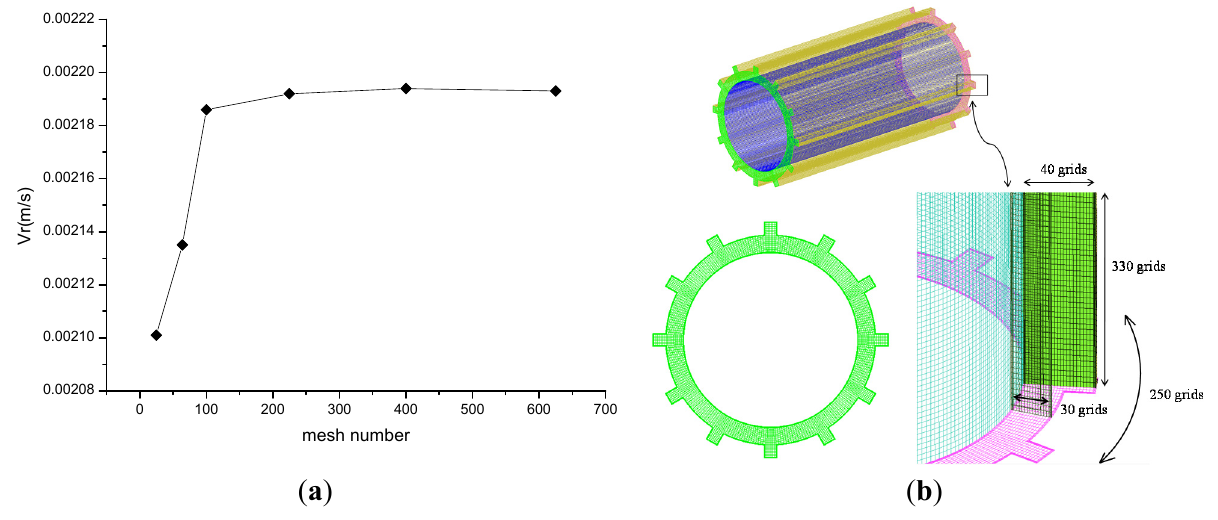
Figure 7. Grid independence study of slit model. ( a ) Simulation results with different grid number; and ( b ) Grid in 12 slit